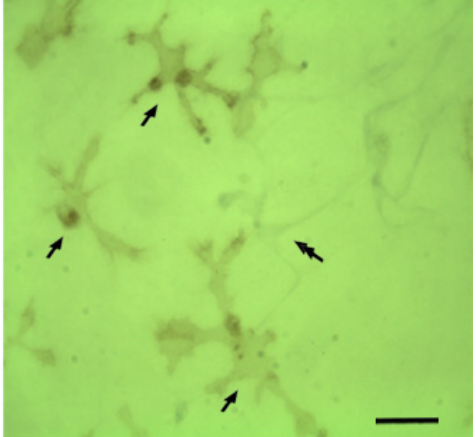
FIGURE 6 – Primary astroglial culture obtained from mouse spinal cord submitted to a two-color immunoperoxidase procedures for simultaneous detection of GFAP (marker for astrocytes) and CD11B (marker for microglia) immunoreactivities. GFAP immunoreactivity is identified as a brownish color (diaminobenzidine as a chromogen) and CD11B immunoreactivity as a bluish color (4-chloro naphthol as a chromogen). Arrows indicate the presence of a large number of immunopositive astroglial cells and the double arrow illustrates the presence of a scattered immunoreactive microglia.